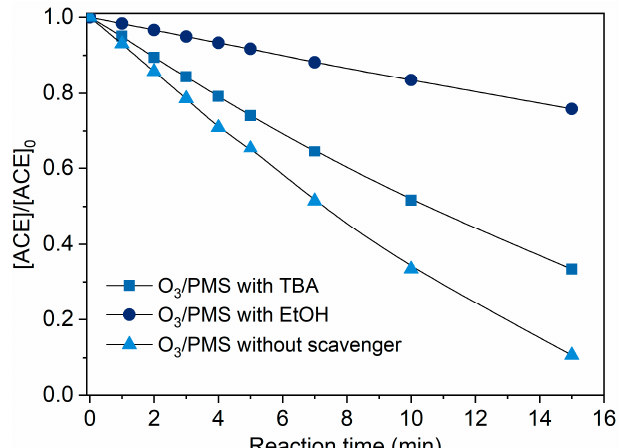
Figure 3. Degradation of ACE by O 3 /PMS in the presence of different scavengers. Conditions: [ACE] 0 = 8.0 mg L − 1 ; pH = 7.4; 15 ± 1 °C; O 3 dosing rate 1.25 ± 0.1 µM·min − 1 (60 ± 5 µg·min − 1 ); [PMS] 0 = 0.4 mM; [TBA] 0 = 0.4 mM; [EtOH] 0 = 0.4 mM).